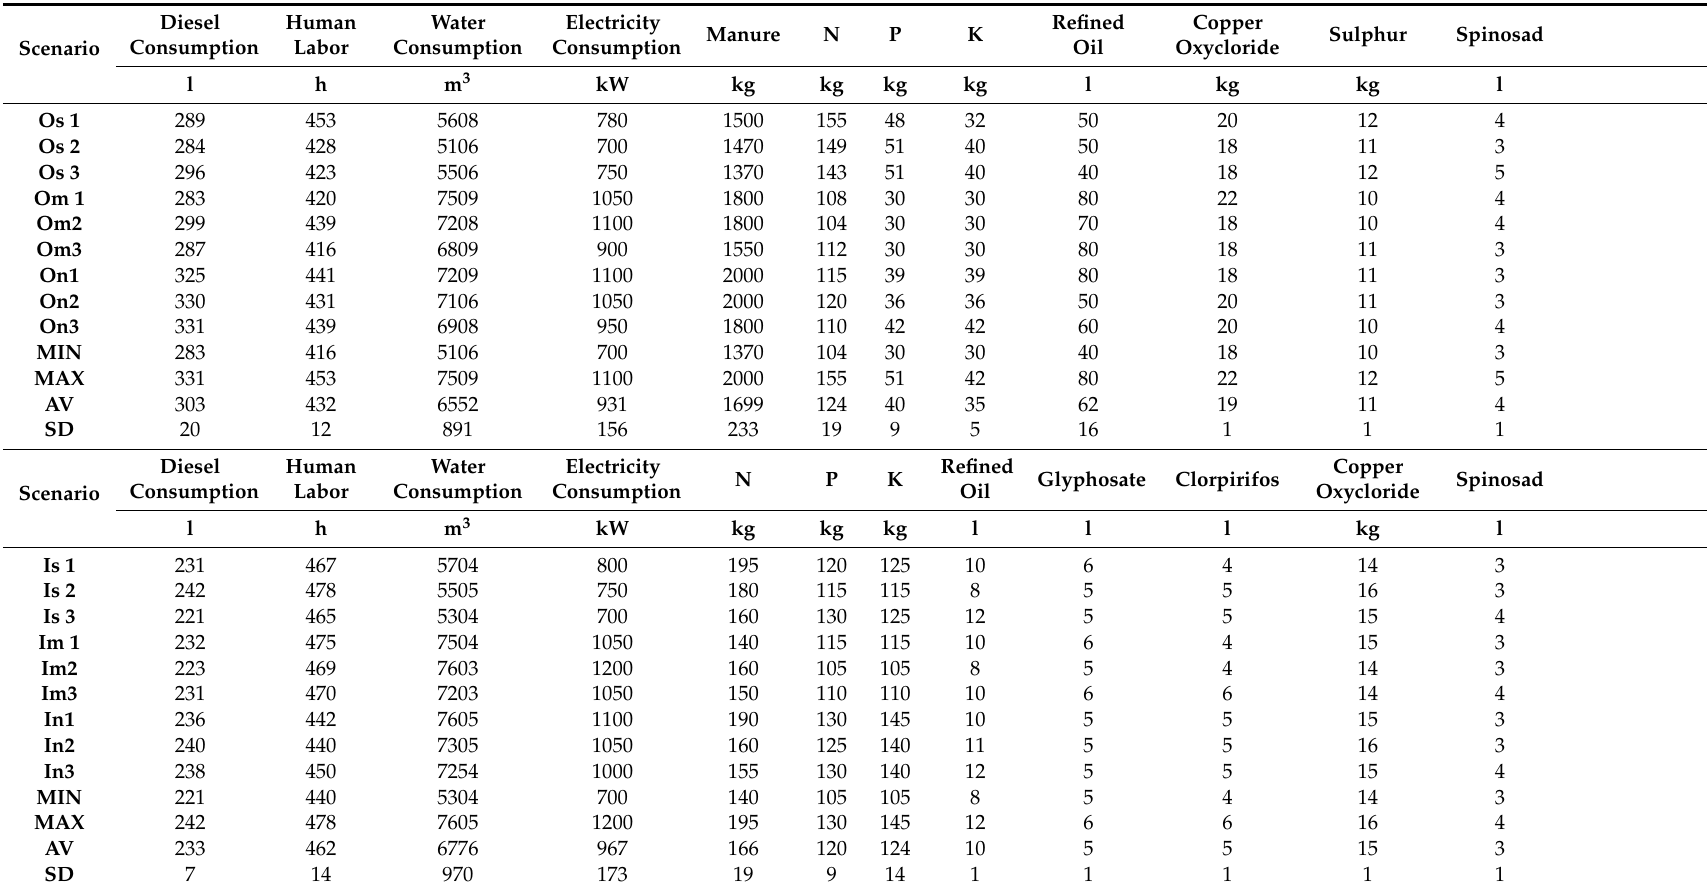
Table 2. Primary data inventory (ha − 1 year − 1